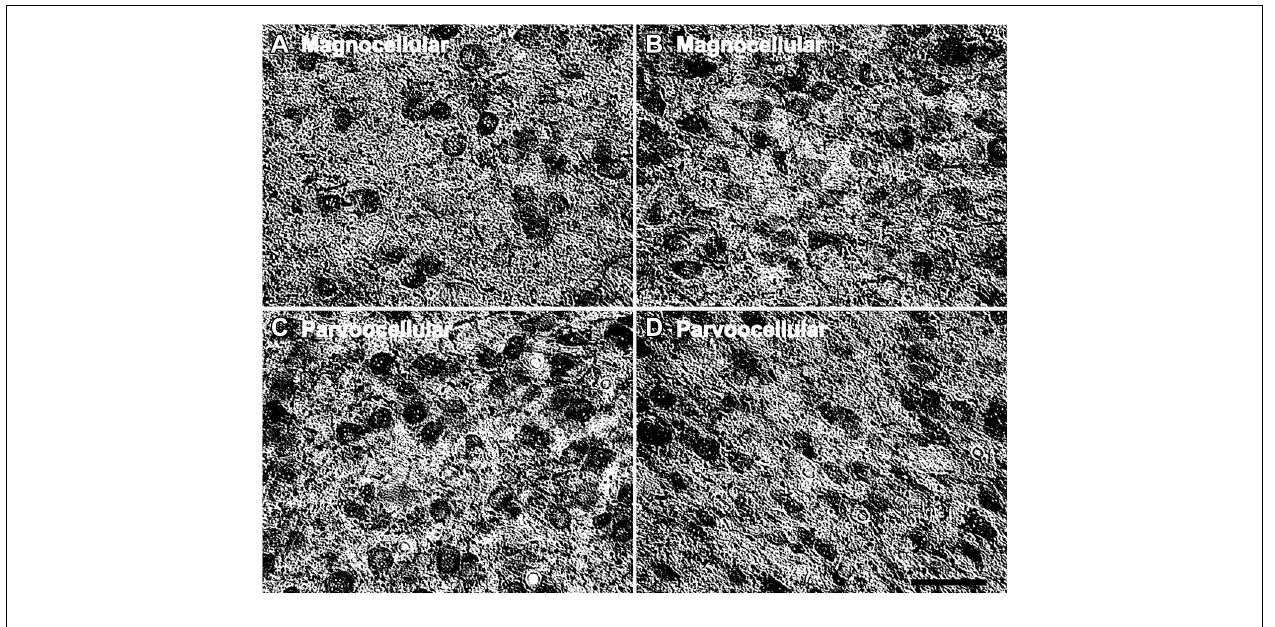
FIGURE 4 |Age-related changes in the number of parvalbumin positive cells in the LGN. Comparison of micrographs from a (A) 15 year old magnocellular layer 2 and (B) 35 year old magnocellular layer 2 reveals apparent age-related increases in the number of PV + cells. Likewise, a